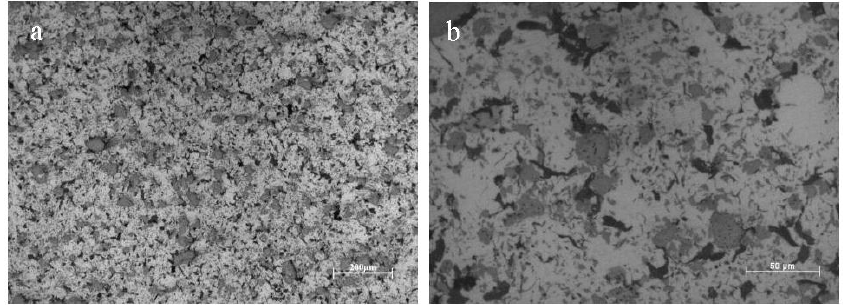
Figure 5. Metallographs of composite along perpendicular direction to that of the compact-pressing: ( a ) 100×; ( b ) 500×.